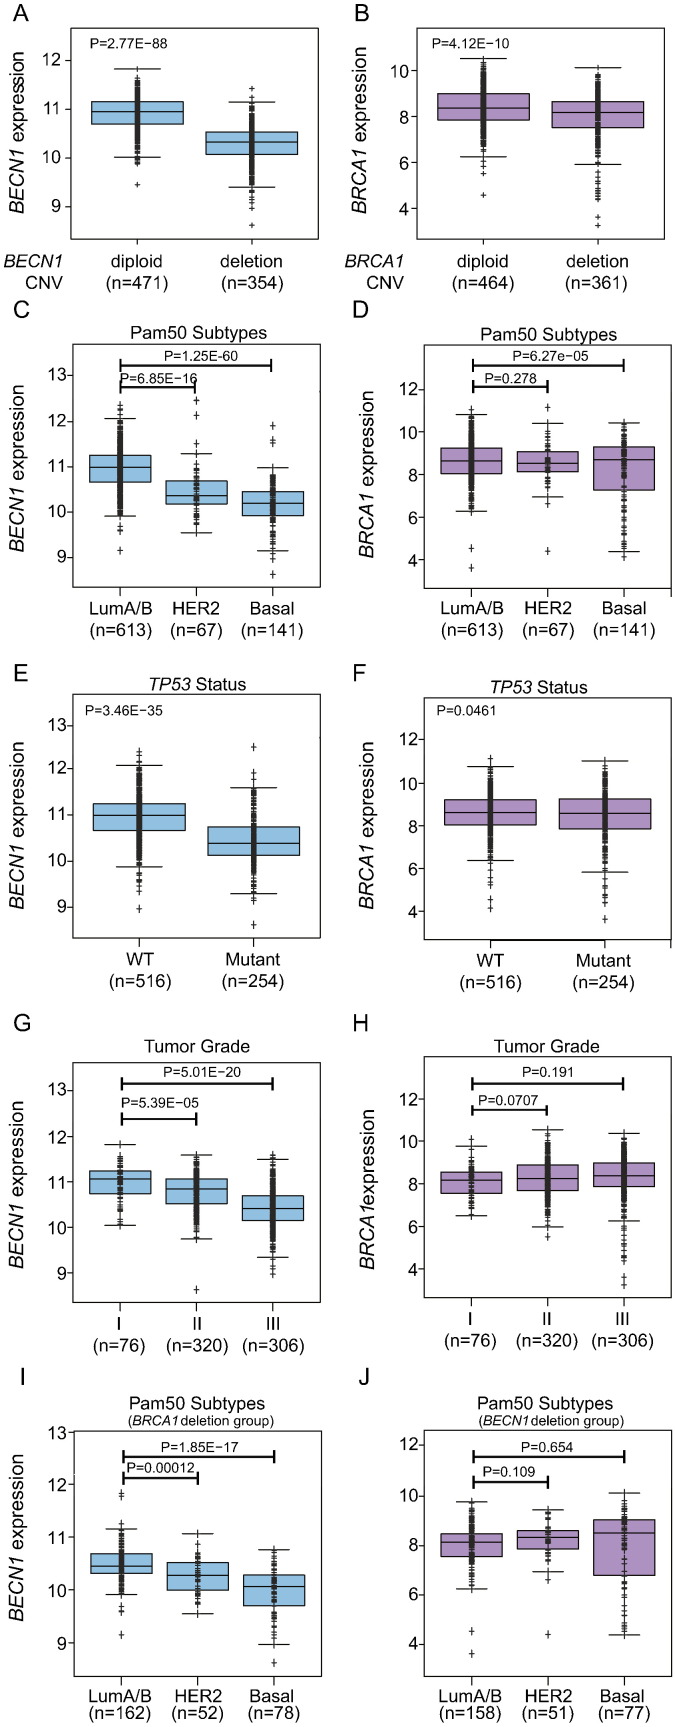
Boxplot showing the distribution of BECN1 expression and BRCA1 expression in TCGA, according to copy number status (panels A and B), PAM50 subtypes (panels C and D), TP53 mutation status (panels E and F), tumor grade (panels G and H), and PAM50 subtypes in copy number loss subgroups (panels I and J). The boxes represent the median (black middle line) and the 25th–75th percentiles (lower and upper box borders). Units for gene expression represent log2 RSEM counts (see Methods).